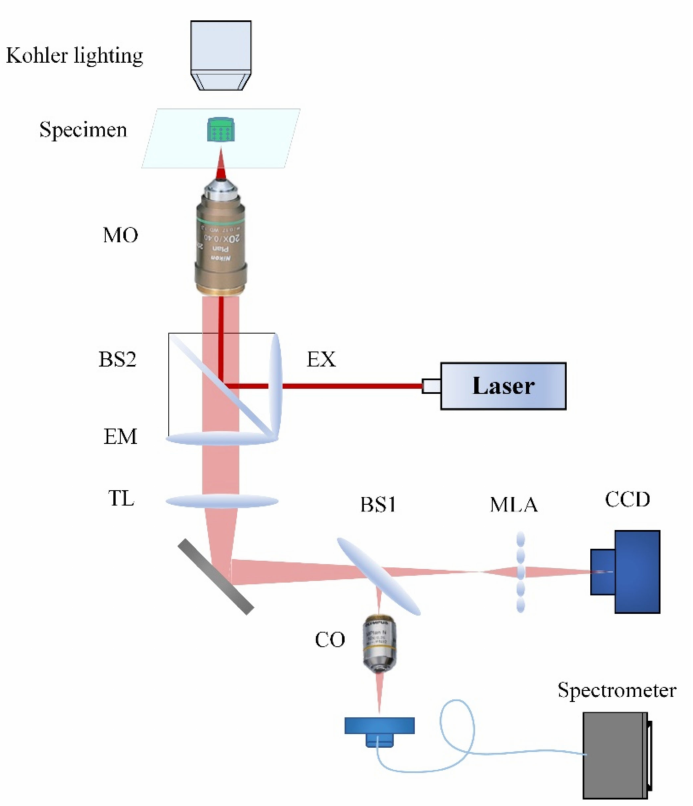
Figure 3. Schematic of the Autostereoscopy-Raman Spectrometry-based three-dimensional metrology